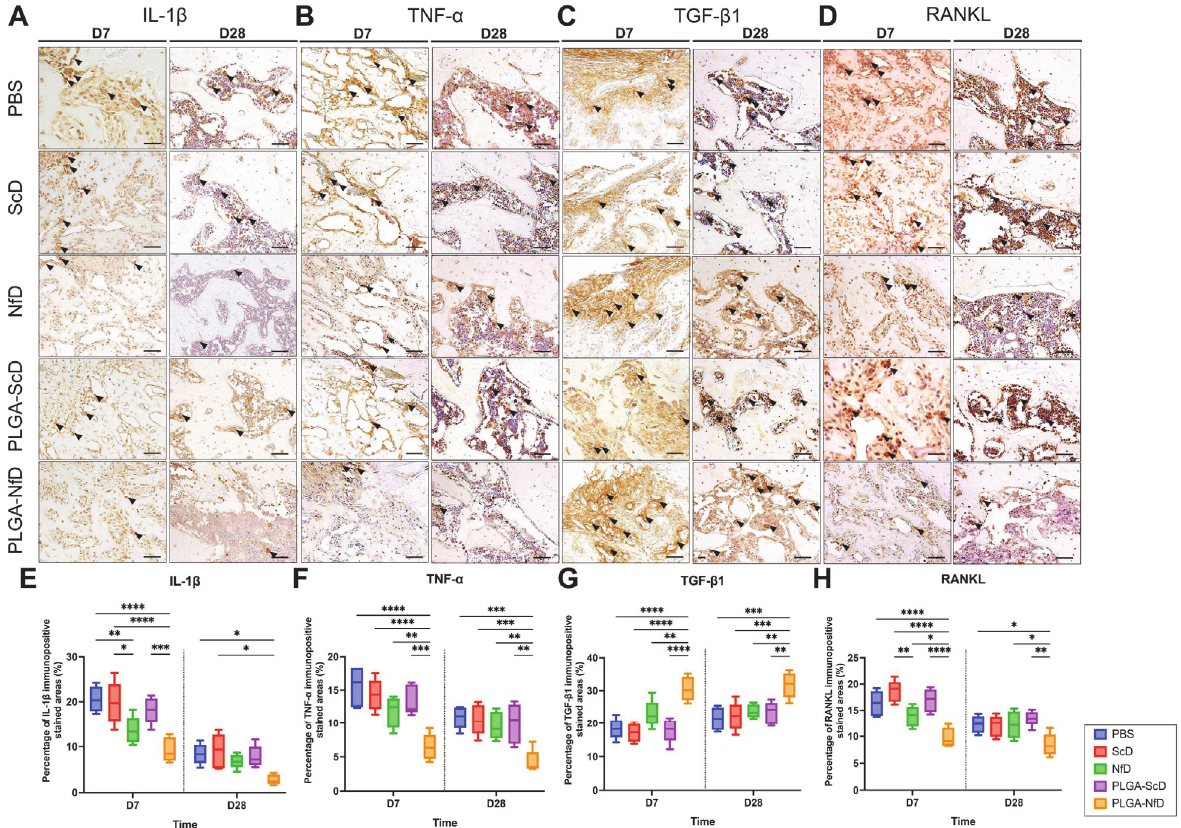
Figure 4. ( A – D ) Representative immunohistochemical staining of IL-1 β , TNF- α , TGF- β 1, and RANKL in the mesial root socket on D7 and D28 after M1 extraction. Magnification: 200 × . Black arrows indicate immune-positive regions. Scale Bar = 100 µm. ( E – H ) Relative semi-quantitative analysis of immunopositive stained areas (%) of the extraction socket. Abbreviations: D7, post-extraction day 7; D28, post-extraction day 28; IL, interleukin; NfD, naked NF- κ B decoy; NF- κ B, nuclear factor-kappa B; ODN, oligodeoxynucleotide; PBS, phosphate-buffered saline; PLGA, poly(lactic-co-glycolic acid); PLGA-NfD, NF- κ B decoy ODN-loaded PLGA nanosphere; PLGA-ScD, scrambled decoy ODN-loaded PLGA nanosphere; RANKL, receptor activator of nuclear factor-kappa B ligand; ScD, naked scrambled decoy; TGF, transforming growth factor; TNF, tumor necrosis factor. Values are presented as mean ± standard deviation ( n = 5). * p < 0.05, ** p < 0.01, *** p < 0.001, and **** p < 0.0001.